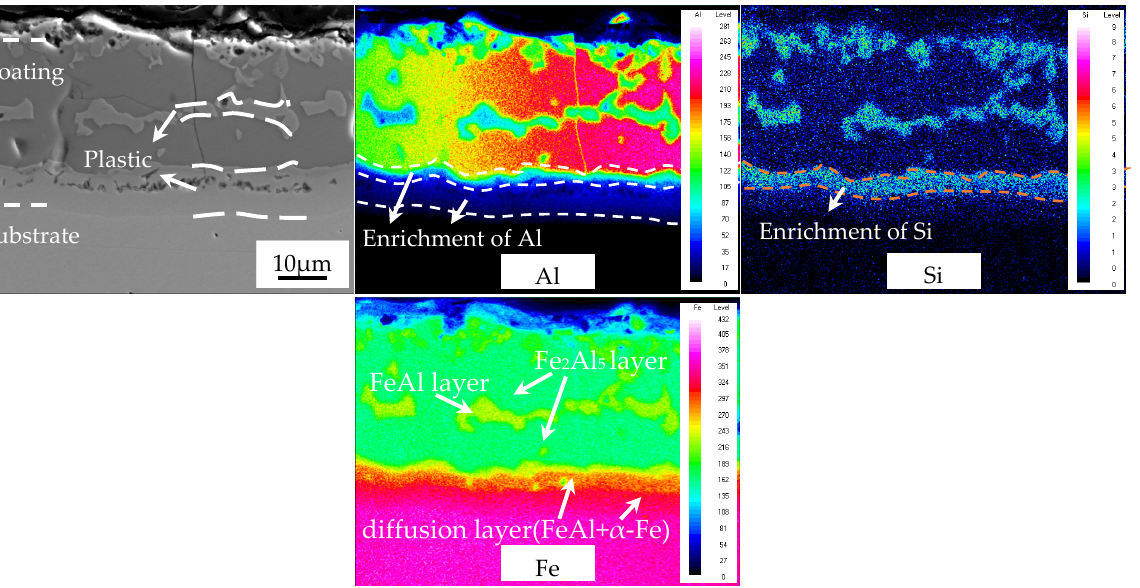
Figure 14. EDS map scan result of interface between the AS60/60 coating and the steel substrate at 0% reduction ratio at TAUS = 930 °C for 5 min.